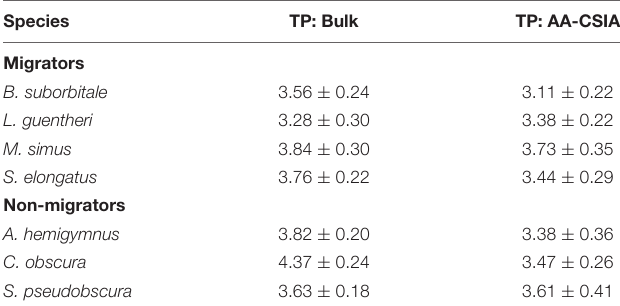
TABLE 5 | Comparison of mean ( ± SD) trophic positions for each fish species created using bulk SIA and AA-CSIA. Species TP: Bulk TP: AA-CSIA